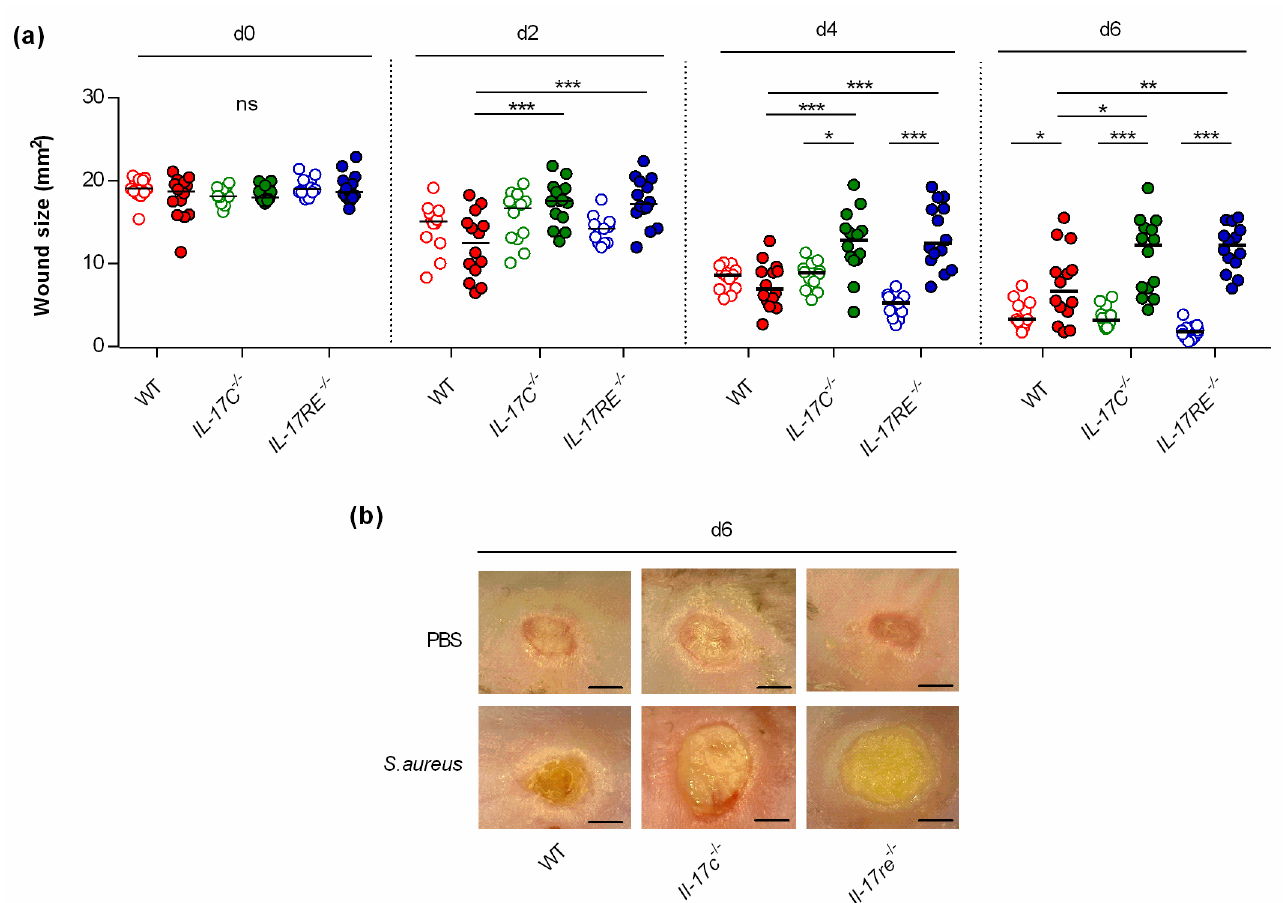
Figure 1. The deficiency for IL-17C and IL-17RE results in a delayed closure of infected wounds. Wounds were introduced into the flanks of WT (red symbols), Il-17c − / − (green symbols) and Il-17re − / − (blue symbols) mice and infected with 10 5 CFU of S. aureus strain Newman (filled symbols) or PBS (open symbols) as control. ( a ) The averaged wound areas (mm 2 ) are shown 0, 2, 4, and 6 days after wounding (n = 12–14 per group). Each symbol represents an individual wound. Horizontal bars indicate the median of all observations. Data were compared by a two-way ANOVA and Holm–Sidak’s post hoc test. * p < 0.05; ** p < 0.01; *** p < 0.001; ns, not significant. ( b ) Representative images of wounds 6 days after wounding. Scale bar, 2 mm.